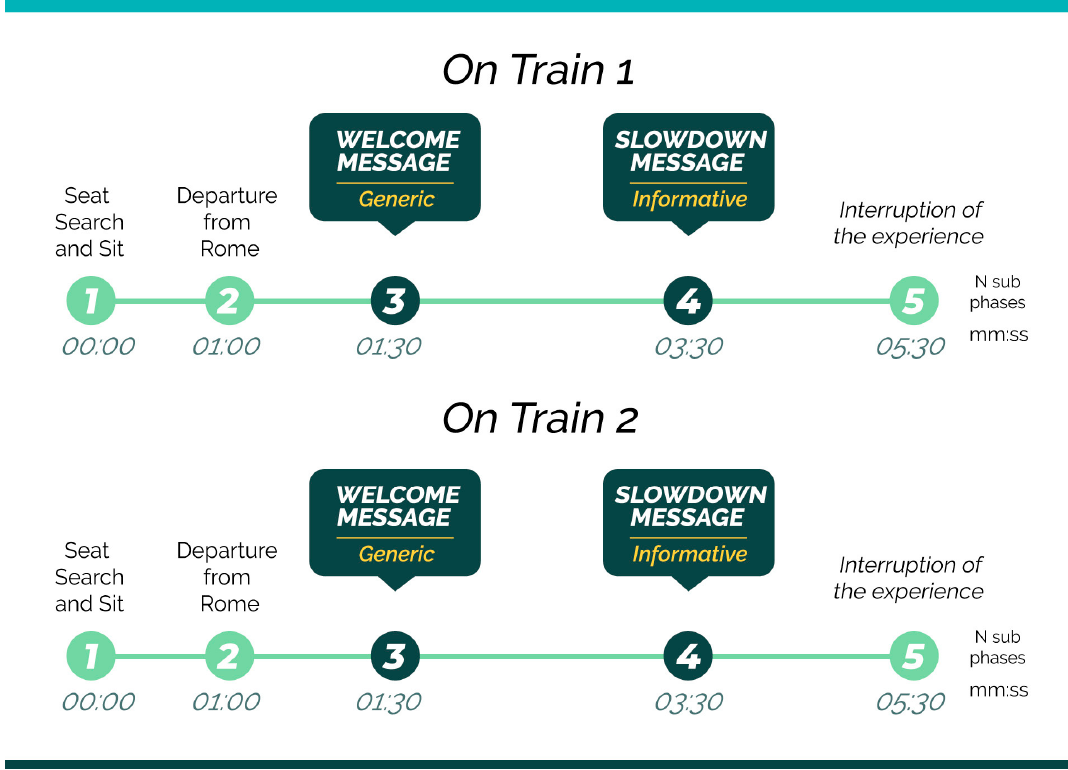
Figure 3. VR train journey: each subphase has been rename with the name of the most representative event happening in that specific time interval. The most significant events, for the purposes of the current study, were represented by the “welcome message” (generic message) and the “slowdown message” (informative message).